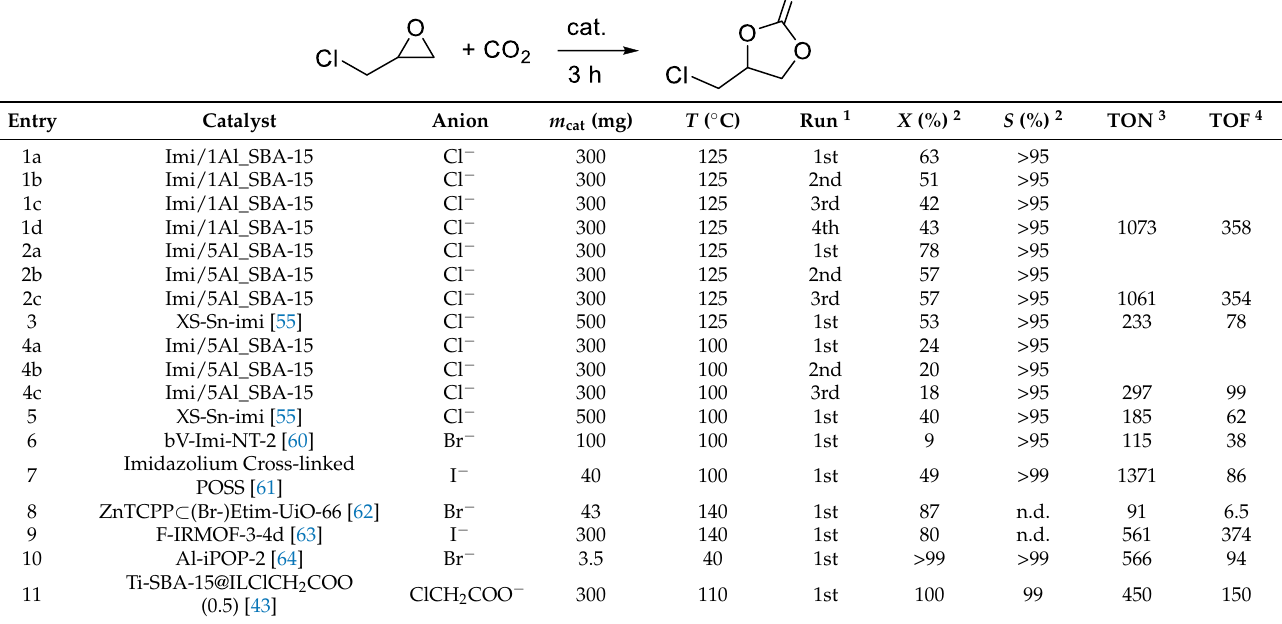
Table 3. Catalytic results for epichlorohydrin conversion to the corresponding cyclic carbonate.